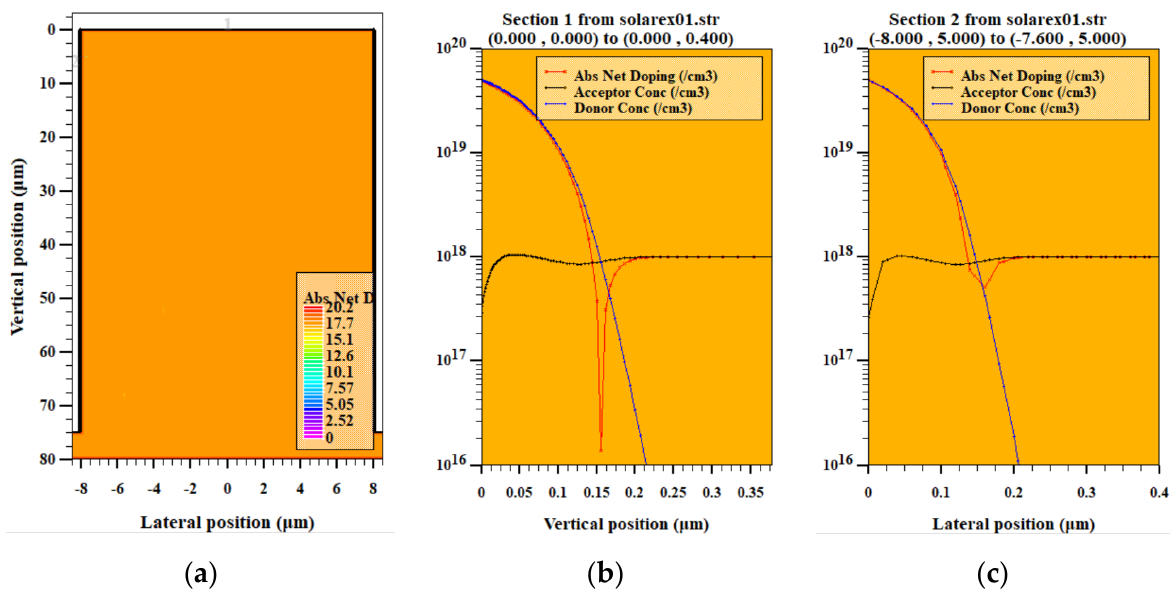
Figure 2. The proposed microstructure generated by Athena process framework ( a ) cross-sectional view for a unit cell illustrating the absolute net doping, ( b ) vertical cutline (through x = 0 µm) to show the doping profile of the top p-n junction and ( c ) lateral cutline (through y = 5 µm) to show the doping profile of left p - n junction.